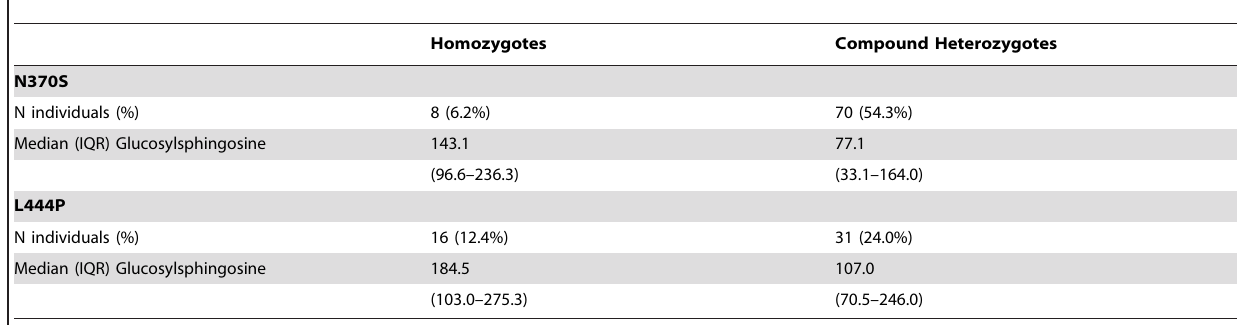
Table 3. Glucosylsphingosine levels in patients carrying frequent Gaucher mutations.